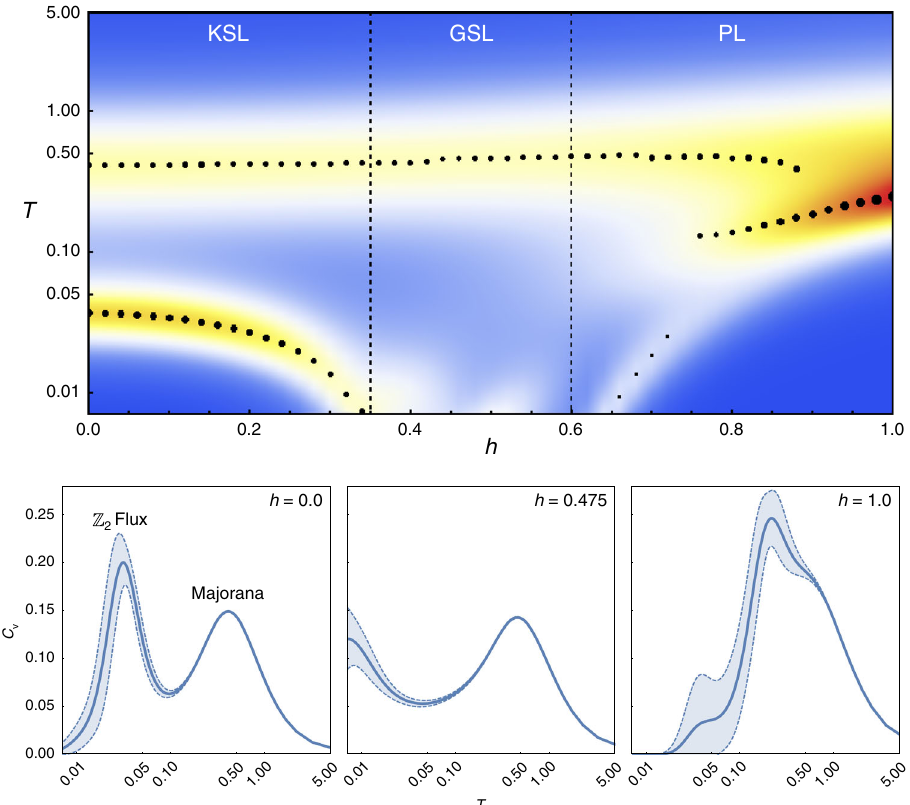
Fig. 5 Speci fi c heat as a function of temperature for increasing fi eld. Shown along the cut at θ = 82.5° (upper panel). The black circles (and their widths) indicate the location (and heights) of the maxima. The three lower panels show speci fi c heat scans for the zero- fi eld KSL, the intermediate GSL at h = 0.475 (note that though it is not shown here, the speci fi c heat goes to zero as T → 0), and the PL state at h = 1.0, respectively. The light blue shading indicates the standard deviation of the